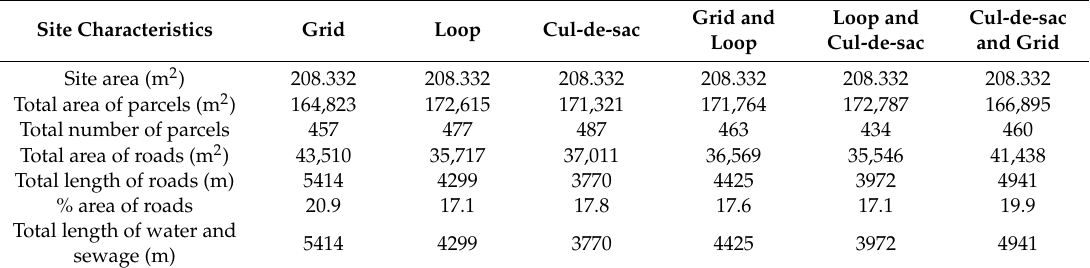
Figure 4. The six development typologies adopted in the virtual development project. Table 1. Site characteristics of the six typologies.